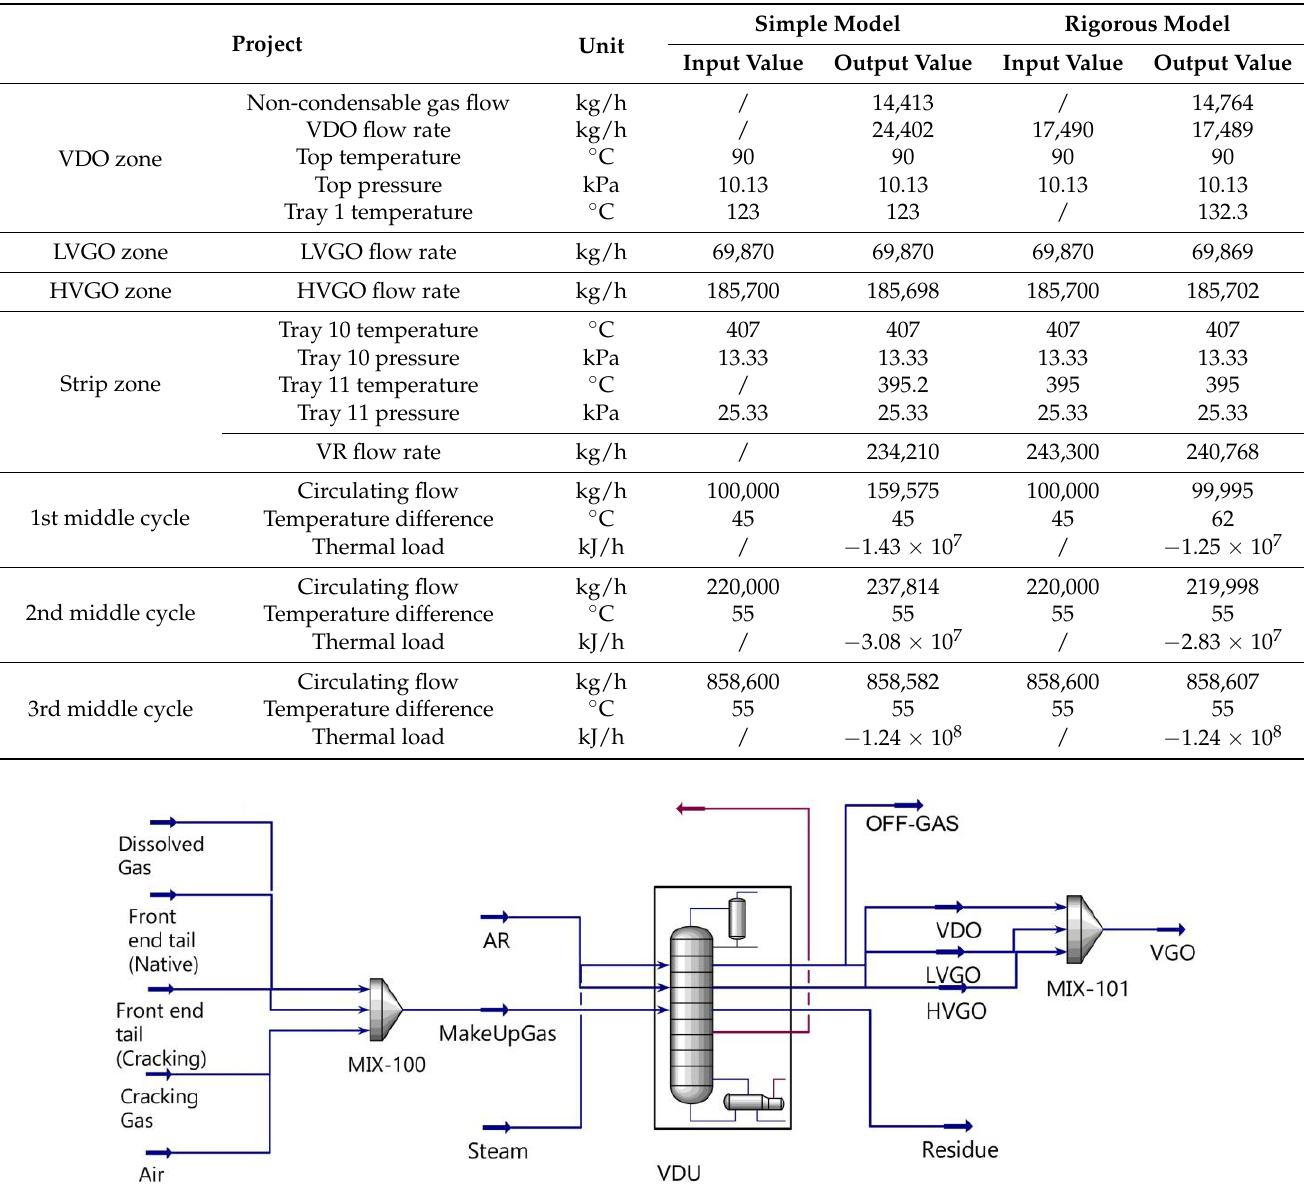
Table 3. The main data involved in simple model and rigorous model simulation.